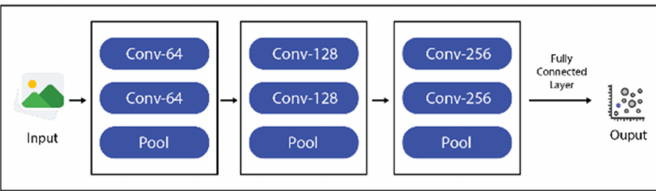
Figure 4. VGG16 CNN